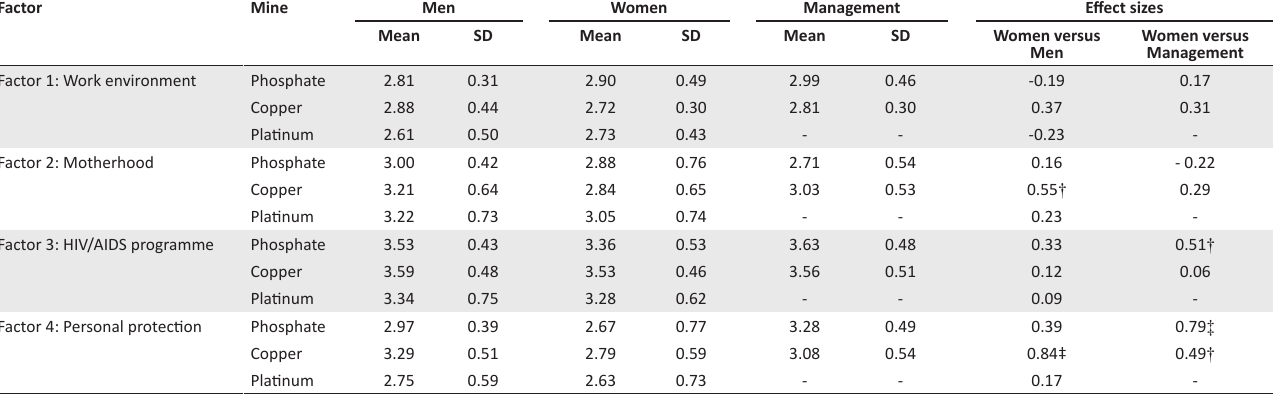
TABLE 7: Comparison of the three target groups of the different mines regarding health and safety in the